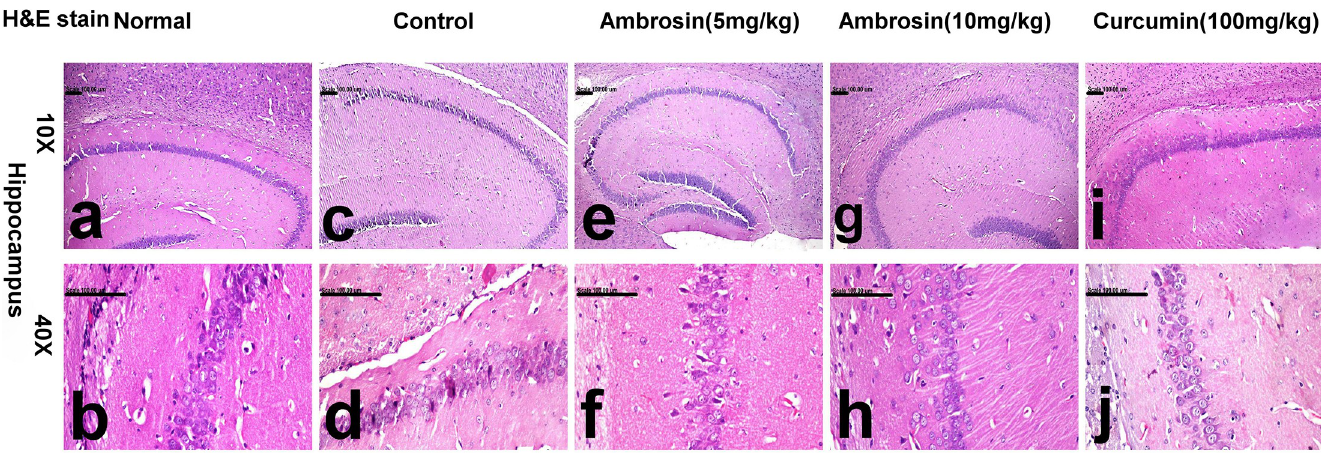
Fig 9. Histopathological lesions in the hippocompus of mice (magnifications: 10X, 40X). The photomicrograph illustrates the following groups: (a, b) normal mice showing normal hippocampal neurons, (c, d) control mice showing extensive degeneration of pyramidal neuronal cells, (e, f) Ambrosin (5 mg/kg/day) treated mice showing decreased number of degenerated neurons, (g, h) Ambrosin (10mg/kg/day) treated mice showing degeneration of individual pyramidal neurons, and (i, j) Curcumin treated mice showing normal neuronal cells. (Haematoxylin and eosin stain, (H&E stain)).